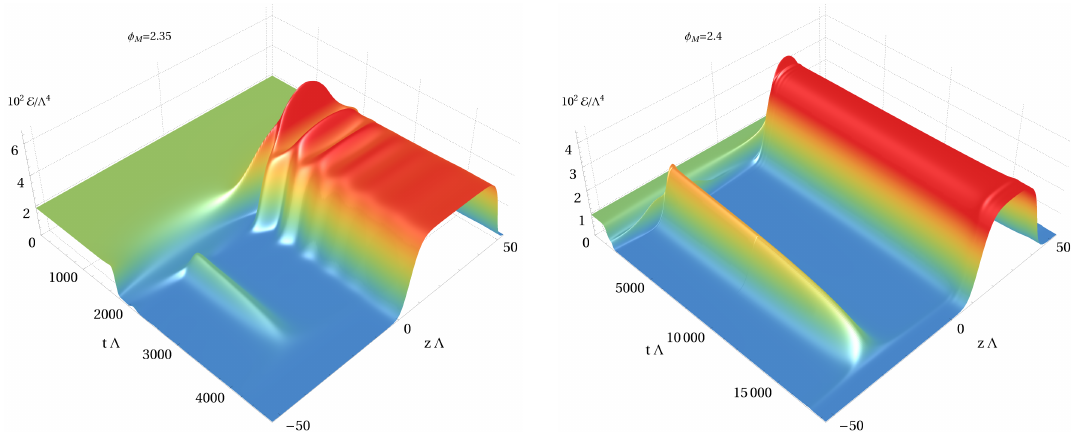
Figure 9 . Two subcritical spacetime evolution of the local energy density demonstrating a dis- sipation of a peak into a plateau with L z λ = 107 , (left) initial homogeneous E ( t = 0) = E 4 and φ M = 2 . 35 up to t Λ = 6250 ; (right) initial homogeneous E ( t = 0) = E 1 and φ M = 2 . 4 up to t Λ = 18350